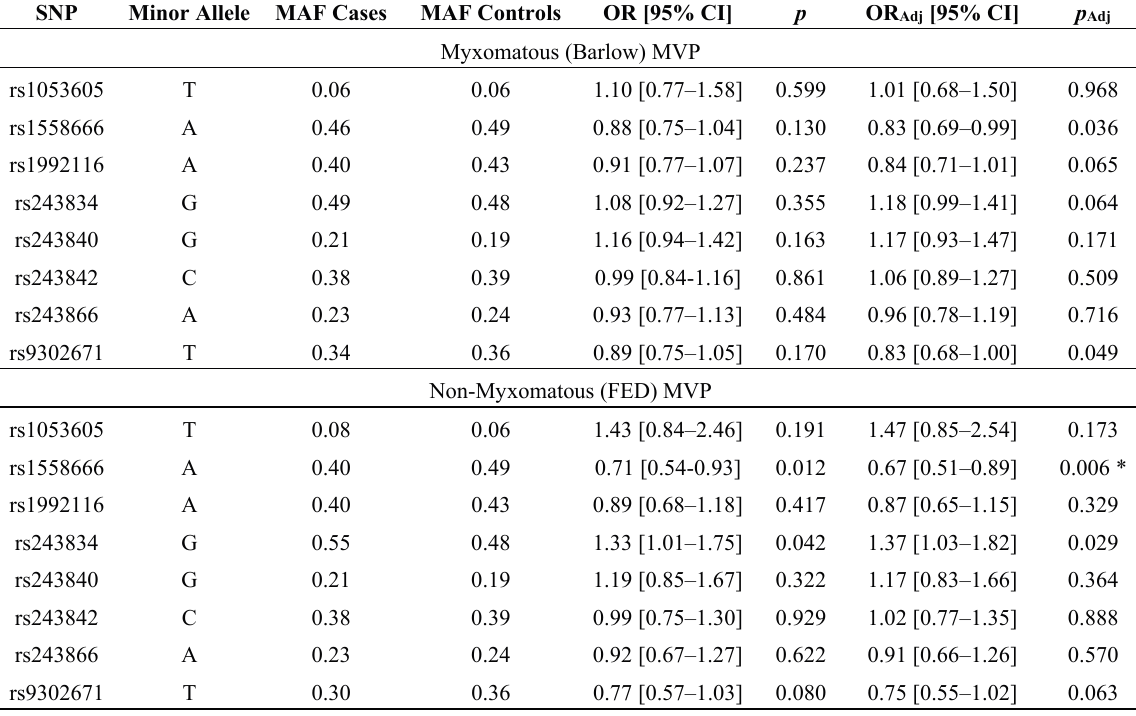
Table 3. Association of MMP2 common tagSNPs with myxomatous (Barlow disease) and non-myxomatous mitral valve